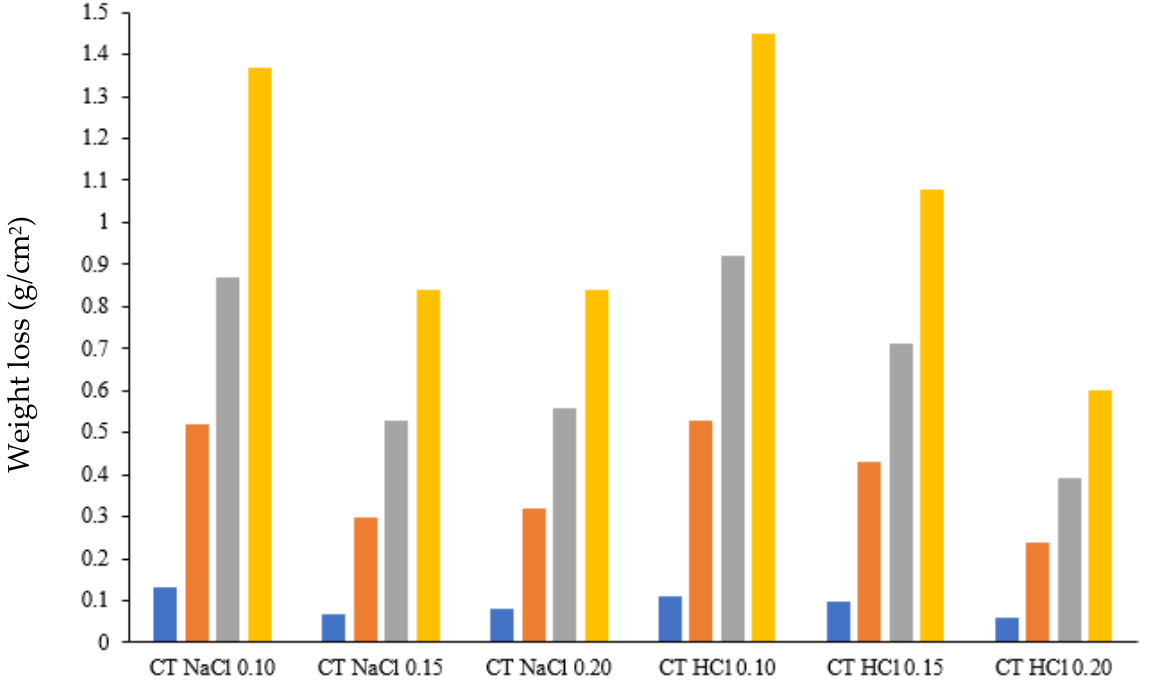
Figure 14. Effect of heat treatment on corrosion behaviour of C .T .